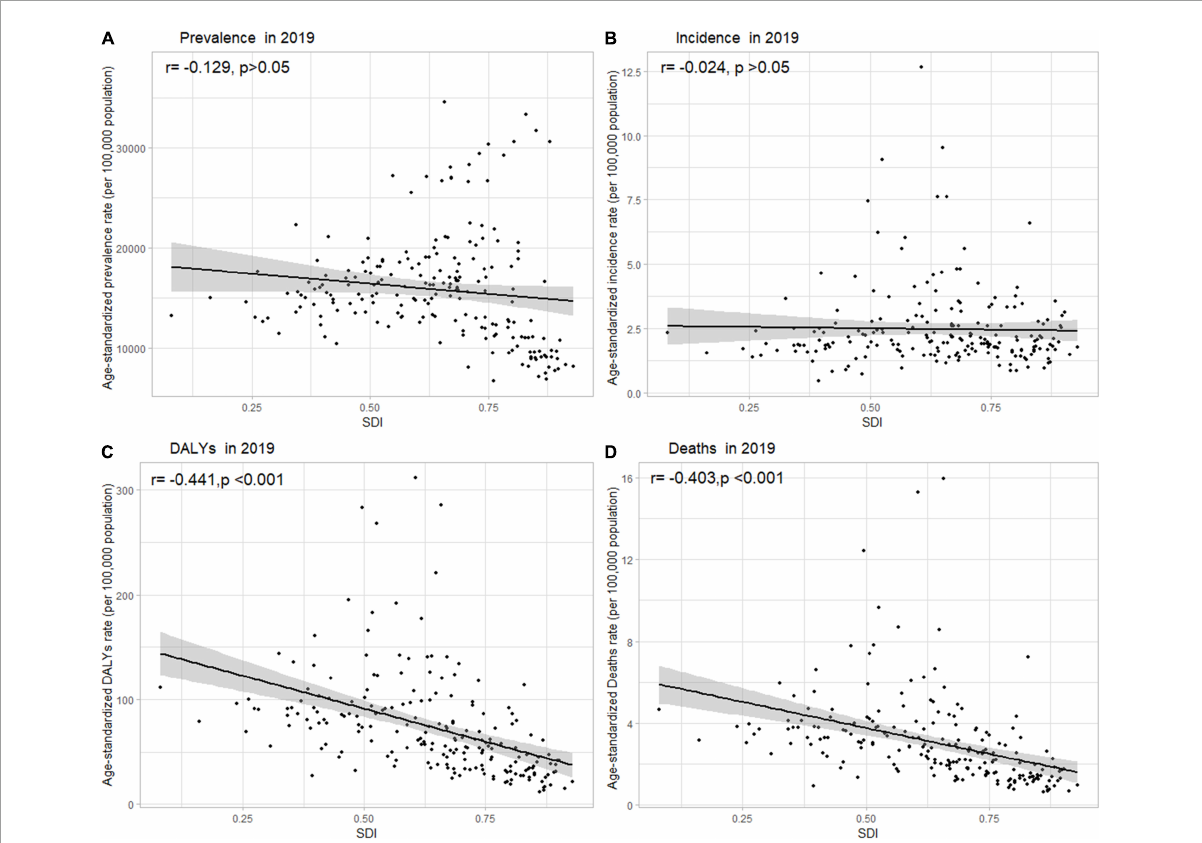
FIGURE3 Age-standardized (A) prevalence, (B) incidence, (C) DALY, and (D) death rates of NAFLD in 204 countries and territories by SDI, 2019. Note: The gray circles represent countries that were available in SDI data; DALY, disability-adjusted life years; NAFLD, non-alcoholic fatty liver disease; SDI, sociodemographic